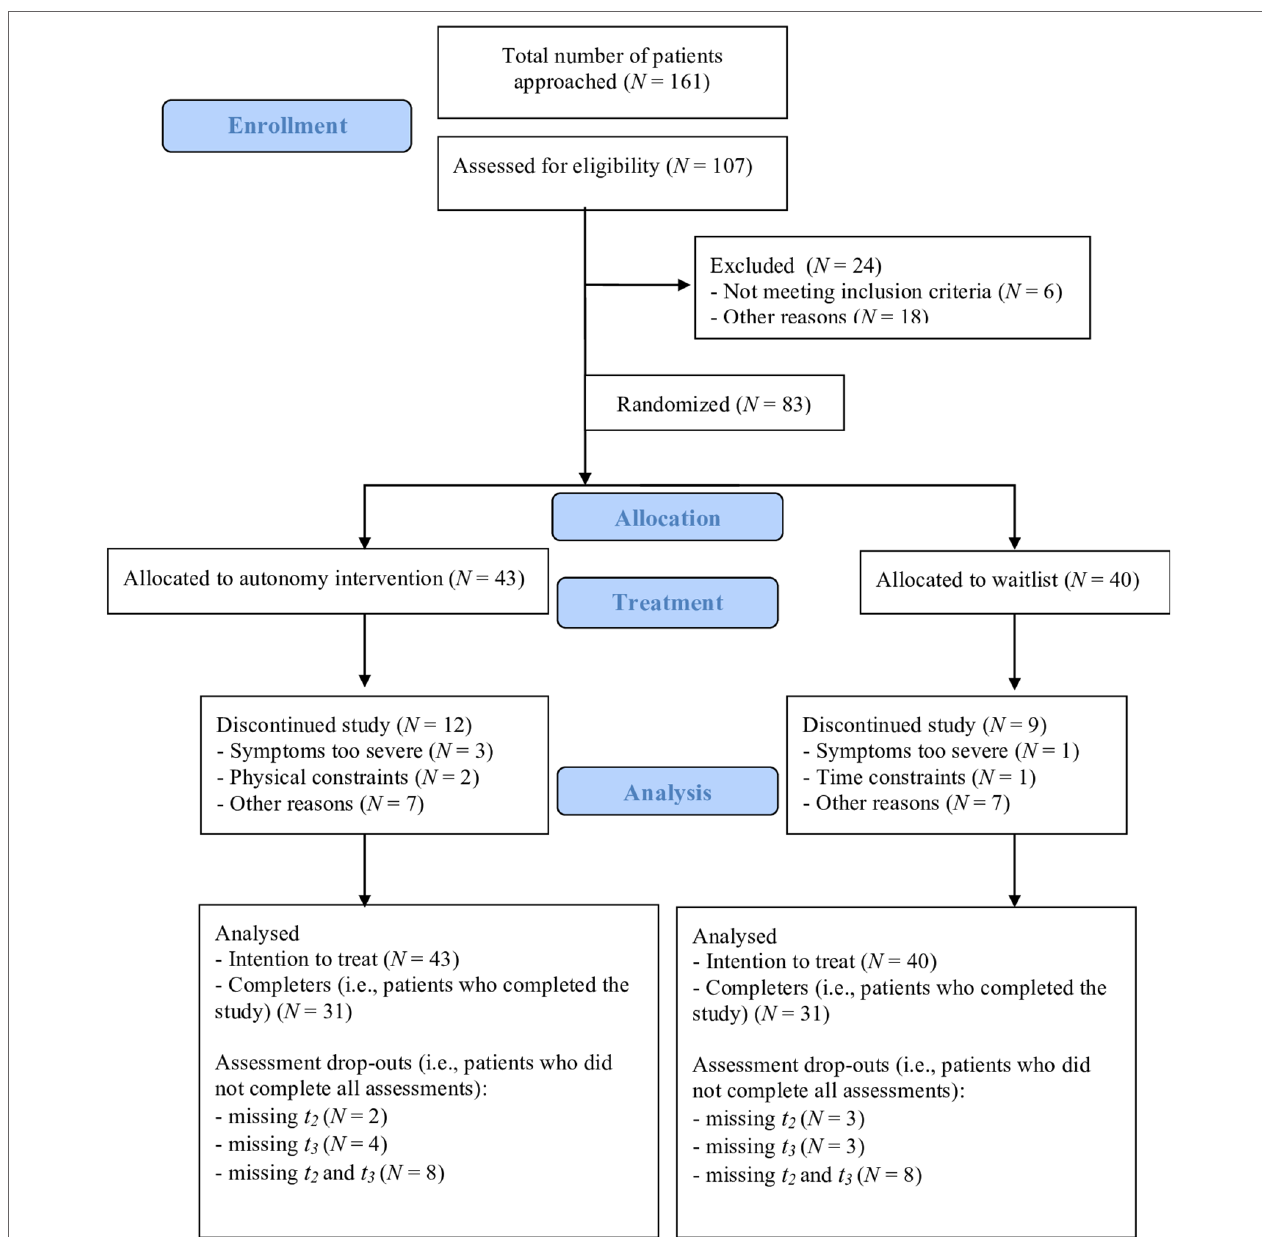
FIGURE 1 | Patient